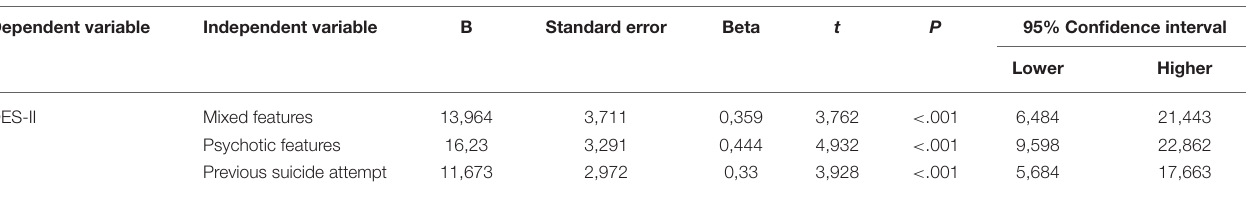
TABLE 3 | Multiple linear regression